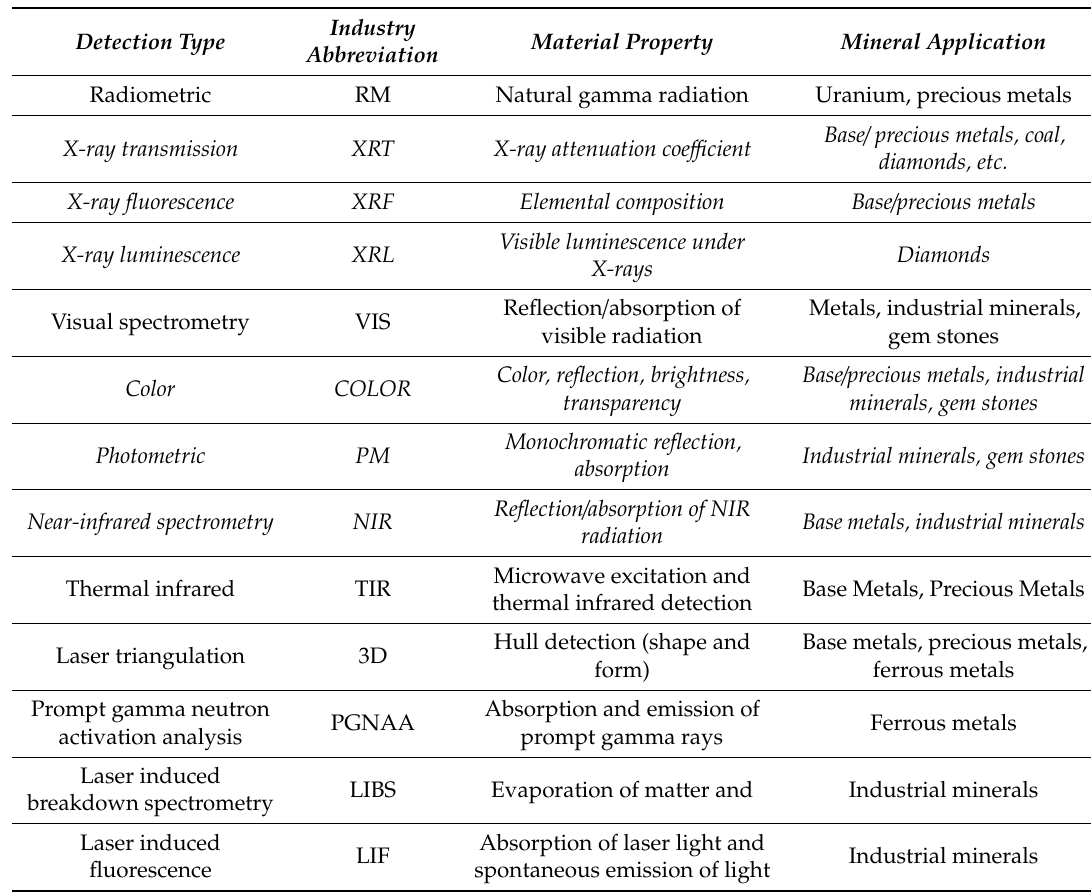
Table 1. Detection systems for sensor-based sorters and exemplary applications in mining (productized systems in italic